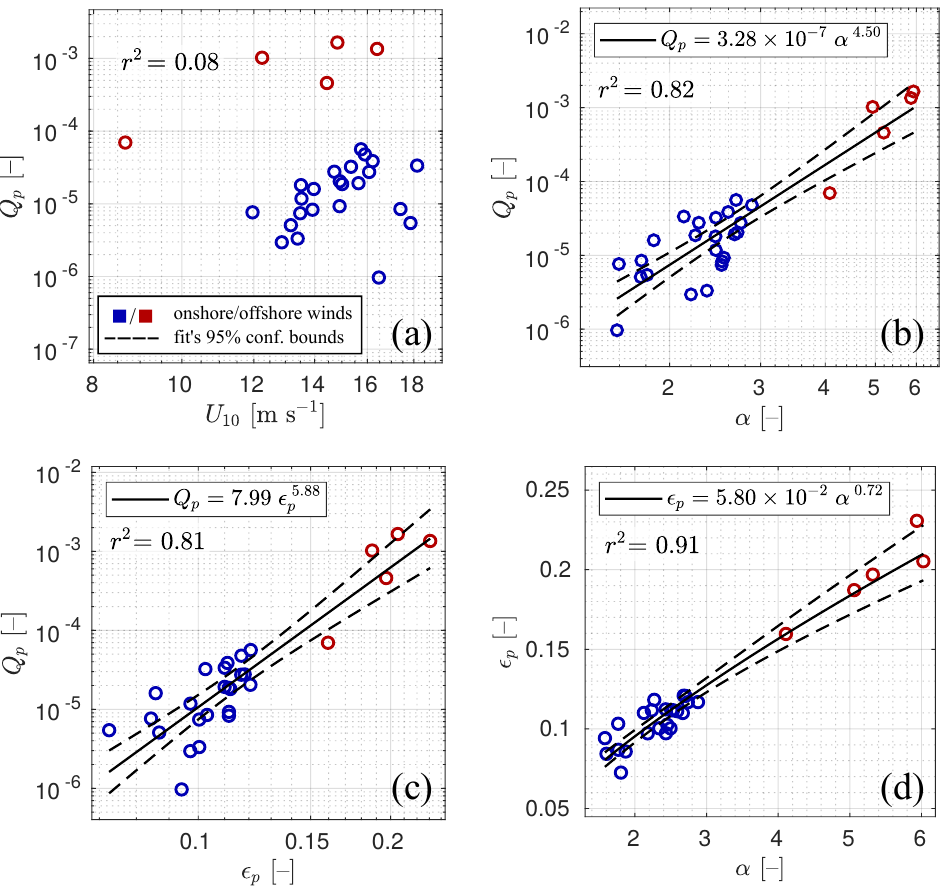
Figure 8. ( a ) The active whitecap coverage of dominant waves, Q p , as a function of the wind speed, U 10 , ( b ) inverse wave age, α , and ( c ) dominant wave steepness, (cid:101) p , ( d ) The α as a function of (cid:101) p . In the subfigures, a squared correlation coefficient, r 2 , and confidence bounds are based on the best linear fit in the log–log domain. For the colour-coding see the